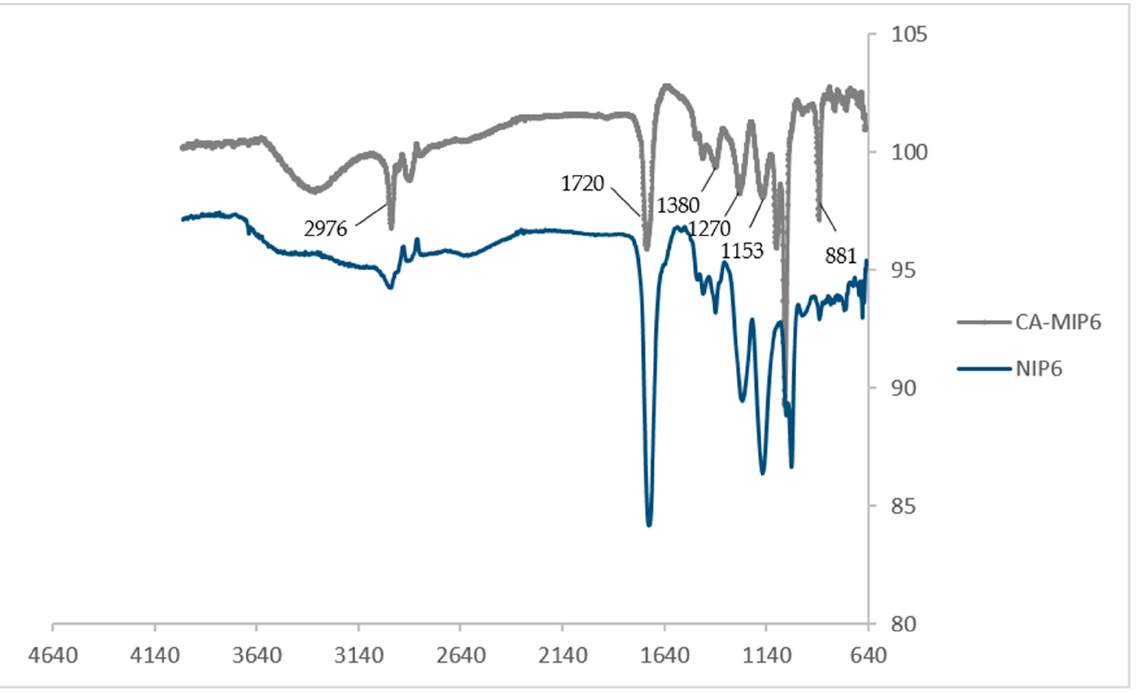
Figure 2. FTIR spectra of CA-MIP6 and NIP6.